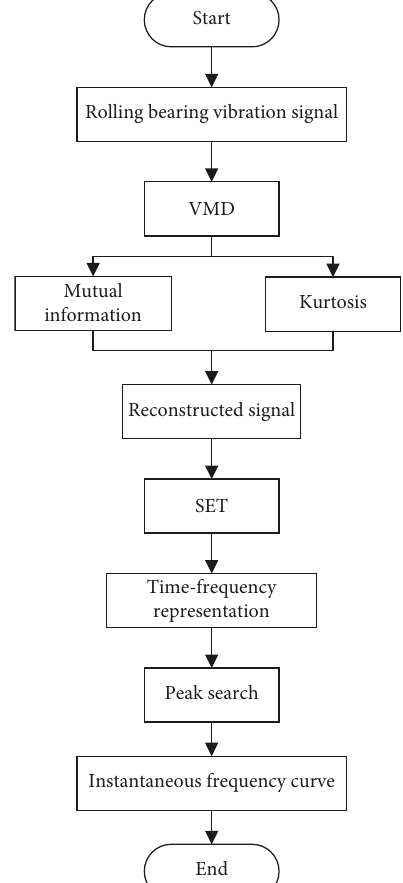
Figure 1: VMD-SET analysis flowchart for instantaneous fre- quency estimation of rolling